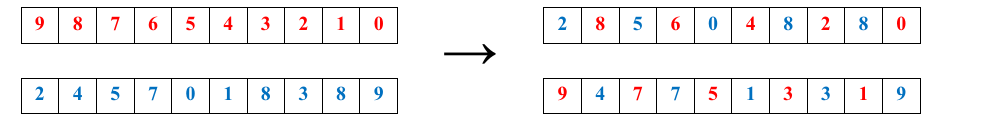
Figure 9. Crossover operation in evolutionary hybrid classifier.